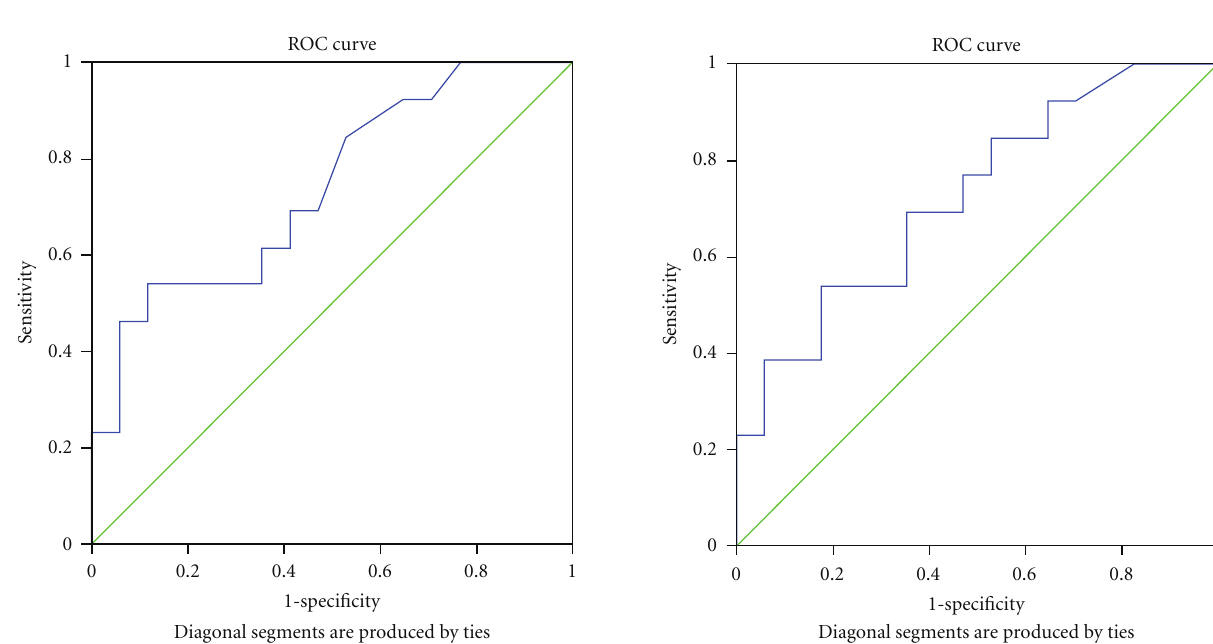
( r = 0 . 454; P = . 012), DPP ( r = 0 . 449; P = . 013), and OA-RI ( r = − 0 . 432; P = .